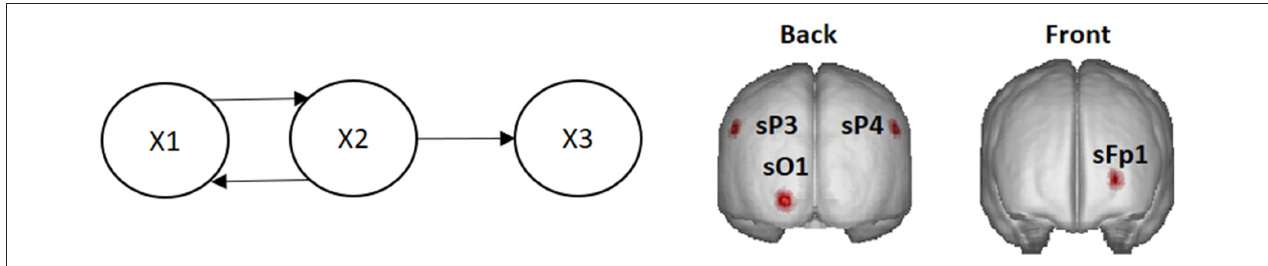
FIGURE 1 | Left : System diagram. The past of X1 influences the present of X2, and vice versa. The past of X2 influences the present of X3. X3 does not influence any variable. Right : Voxels in the cortex used as locations of point sources in the simulations (named according to the 10–20 EEG recording system).